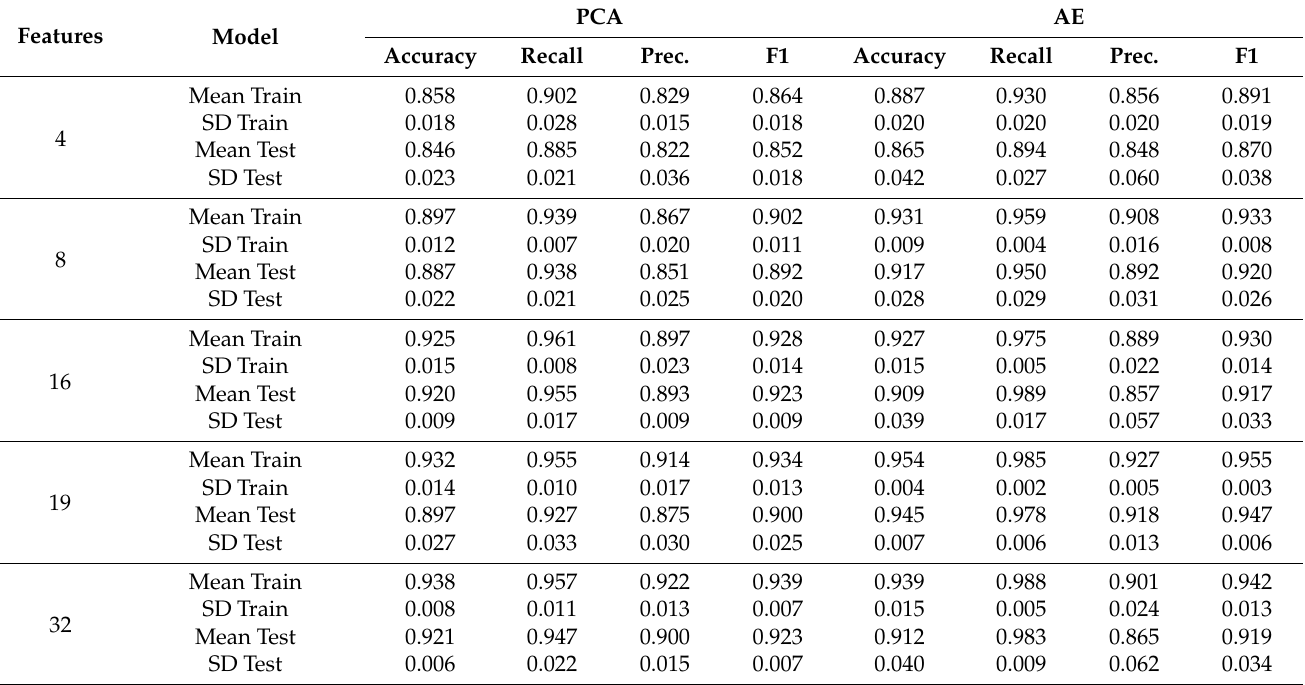
Table A4. Binary classification metrics for SVM-RBF kernel per number of PCs and AE latent space dimensionality.